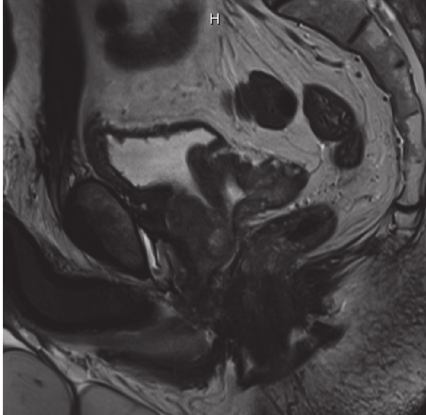
Figure 2: Axial image of the left side of the prostate from sagittal view demonstrating filling of simple prostatectomy defect with